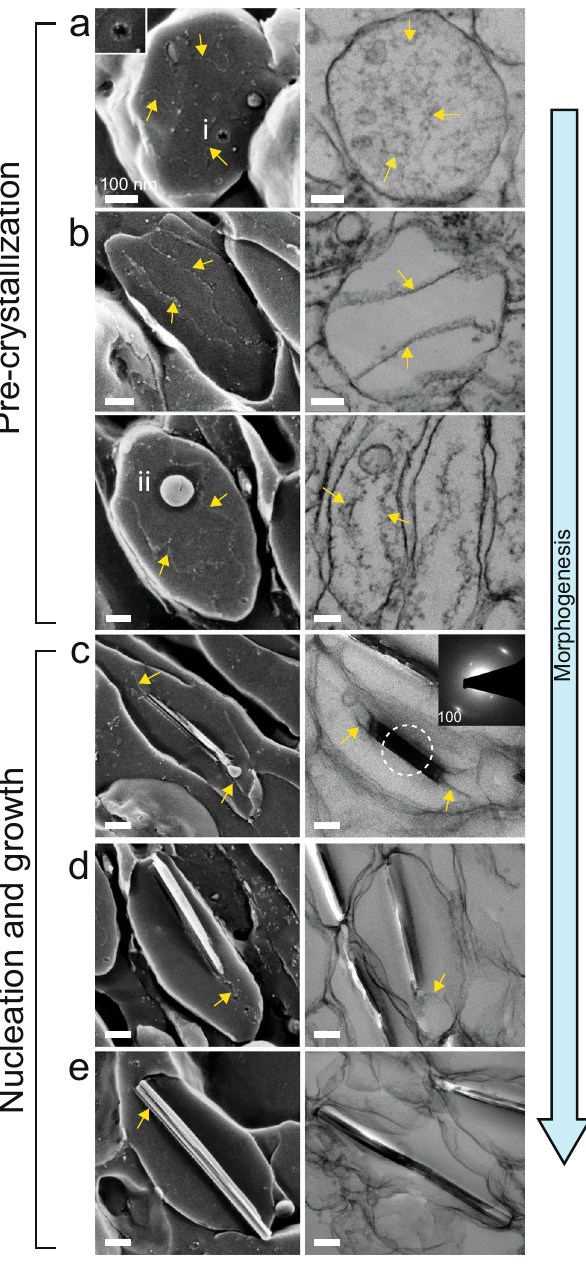
Fig.2|Themorphogenesisofguaninecrystalsinajuvenilescallopeyebycryo- SEM (left column) and TEM (right column). a , b Pre-crystallization: a Spherical